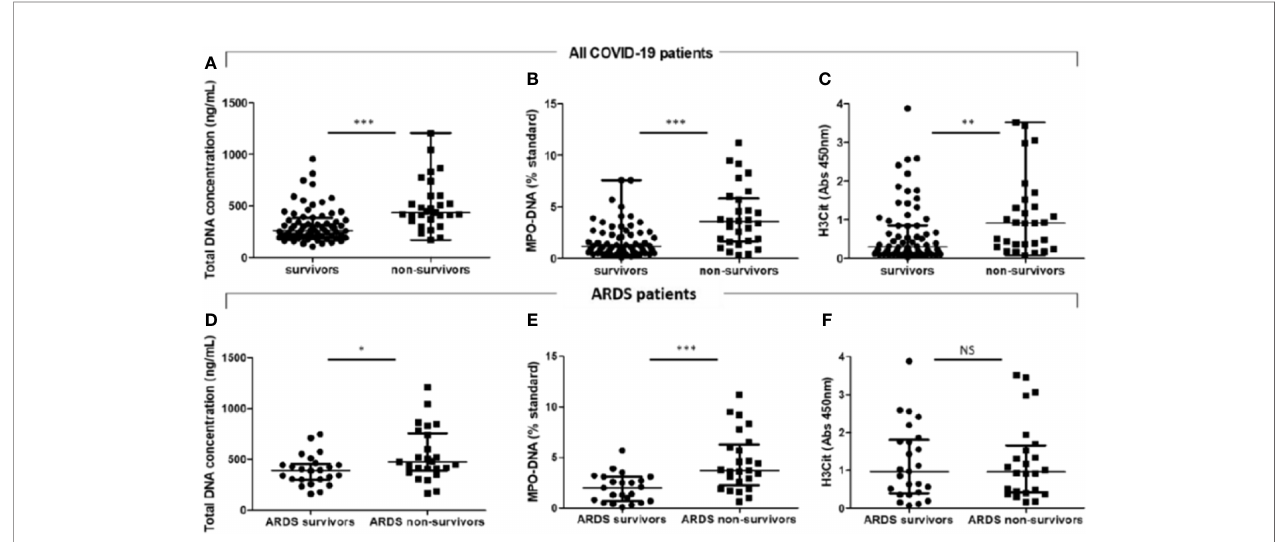
FIGURE 3 | COVID-19 acute respiratory distress syndrome non-survivors have higher plasma total DNA concentrations and myeloperoxidase – DNA levels than survivors. Plasma NET levels were compared in all COVID-19 patients between survivors (n = 67) and non-survivors (n = 29). (A) Total DNA concentration (ng/ml). (B) Myeloperoxidase – DNA levels (% standard NETs). (C) Histone H3 citrullinated (absorbance 450 nm). Plasma NET levels were compared between COVID-19- related acute respiratory distress syndrome (ARDS) survivors (n = 25) and non-survivors (n = 25). (D) Total DNA concentration (ng/ml). (E) Myeloperoxidase – DNA levels (% standard NETs). (F) Histone H3 citrullinated (absorbance 450 nm). Threshold for statistical signi fi cance was a p-value of 0.05. *p < 0.05, **p < 0.01, ***p < 0.001. NS, statistically non-signi fi